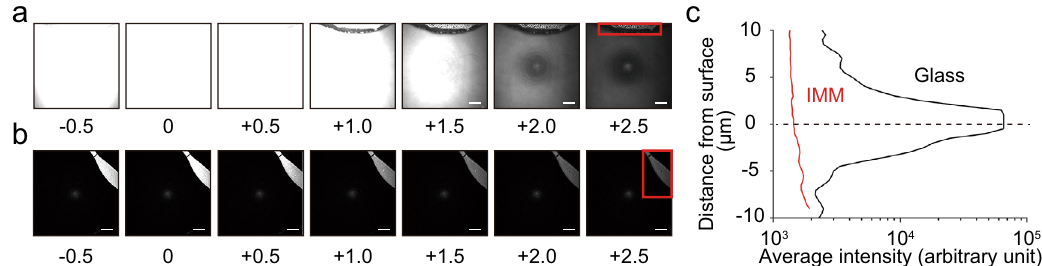
Figure 2. Z-stack images of the interface between ( a ) glass and water or ( b ) MY-133-EA and water. Numbers under images show z-positions from the interface (unit: μm). The red frame shows the region of paint mark. The z-position of the interface was defined as the position where the average signal intensity of the paint mark is maximum. The images were obtained by optical system equipped with a 561-nm continuous wave laser, a 60 × oil-immersion lens (NA = 1.4, RI = 1.515) and a pinhole of 1.2 AU. The z-resolution is 0.5 μm. Bars are 20 μm throughout. Note that deterioration of NA by IMM was not taken into account to calculate resolution. ( c ) Average signal intensities in a field of view around the solid–water interface. The region of the paint mark was excluded from